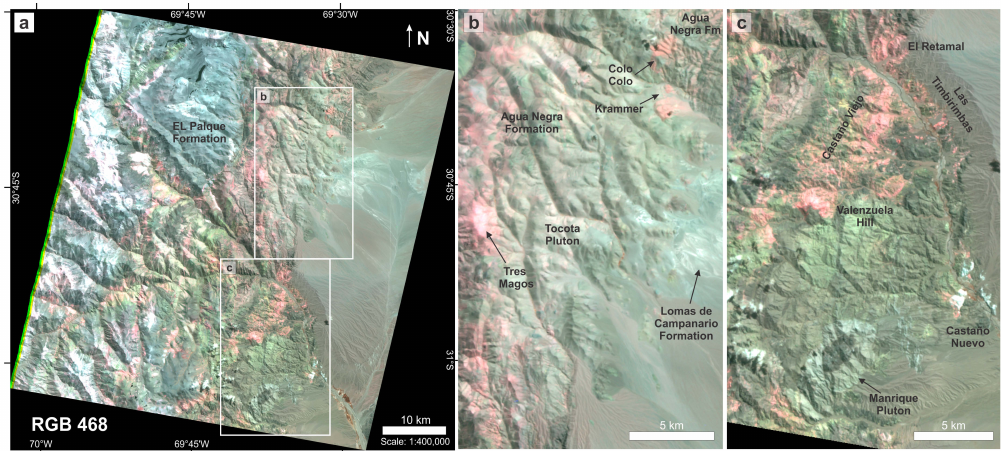
Figure 5. ( a ) False color composite image with ASTER bands 468 (RGB). ( b ) The San Francisco de los Andes district: Tocota Pluton (light green), Loma del Campanario (whitish green), Agua Negra Formation (dark green), Tres Magos alteration zone (whitish pink), and Colo-Colo – Krammer alteration zone (pink). ( c ) The Castaño area: argillic – phyllic alteration (pink), silicic alteration (white to light blue), Manrique Pluton and rhyolitic dykes (greenish blue). Compare the current ASTER imagery with the geologic map in Figure